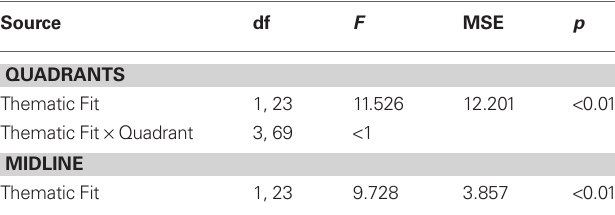
FiguRE 2 | (A) Grand-average waveforms for ERPs elicited by the thematic role violations (dotted, blue line) and the baseline condition (solid, black line) for electrodes CP1, P3, and Pz. (B) The scalp topography of the mean difference between the thematic role violations and the baseline condition within the N400 time window (between 300 and 500 ms after critical word Table 4 | Analysis of variance for the mean ERP amplitudes in the 300–500 ms time window for the thematic role manipulation.